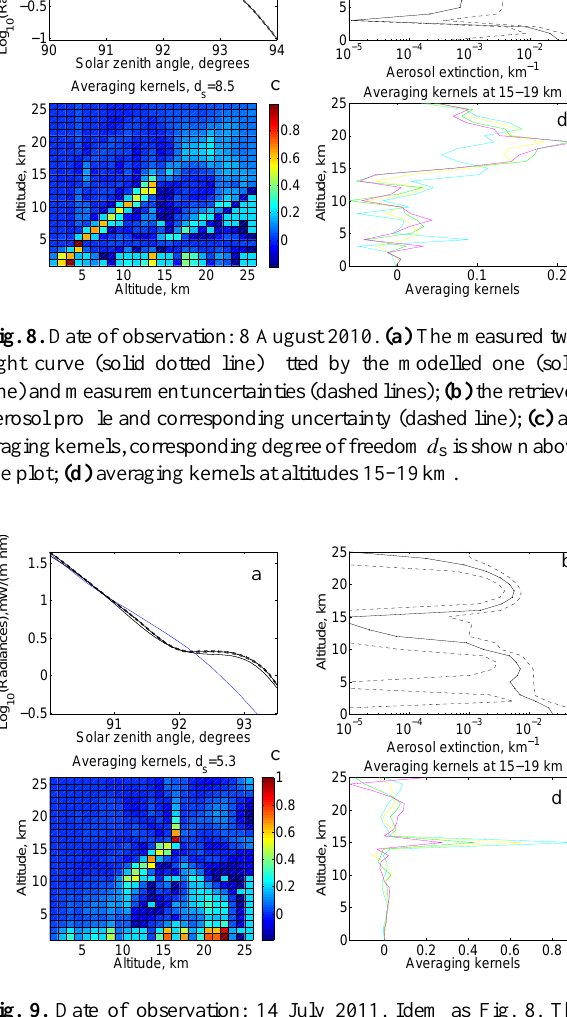
Fig. 9. Date of observation: 14 July 2011. Idem as Fig. 8. The blue line on the panel (a) shows a background twilight curve (24 June 2011).